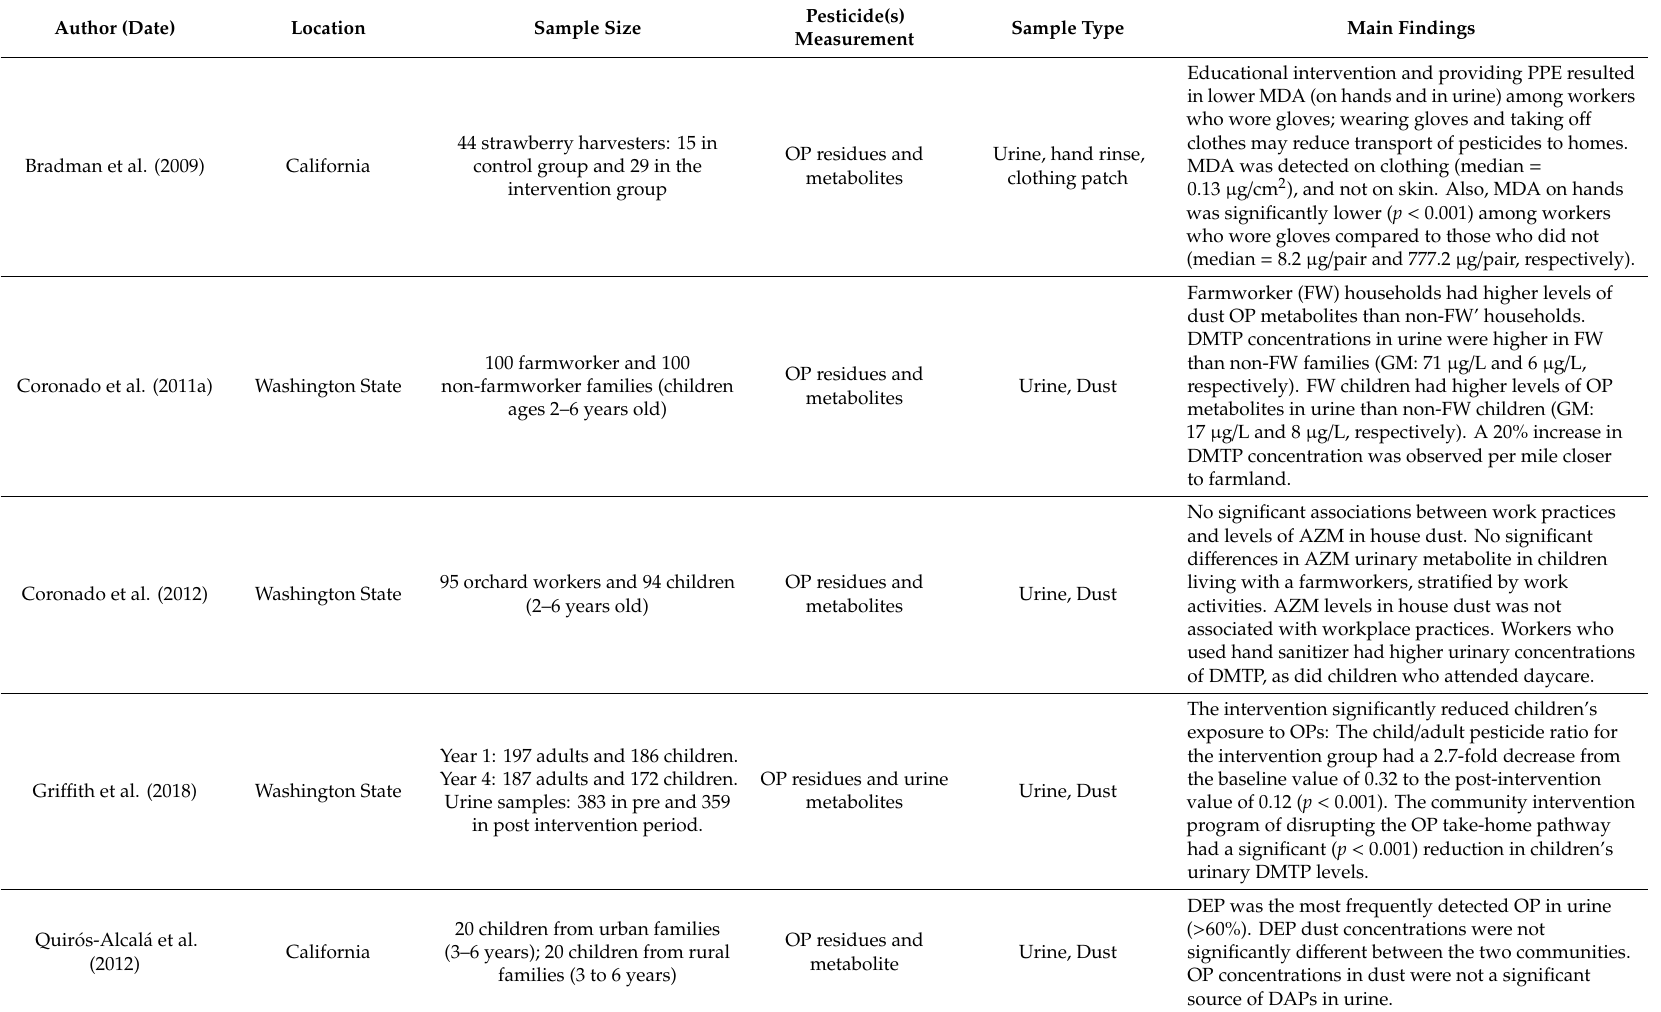
Table 3. Literature review summary on take-home pathway of pesticide exposure—dust and urine sample